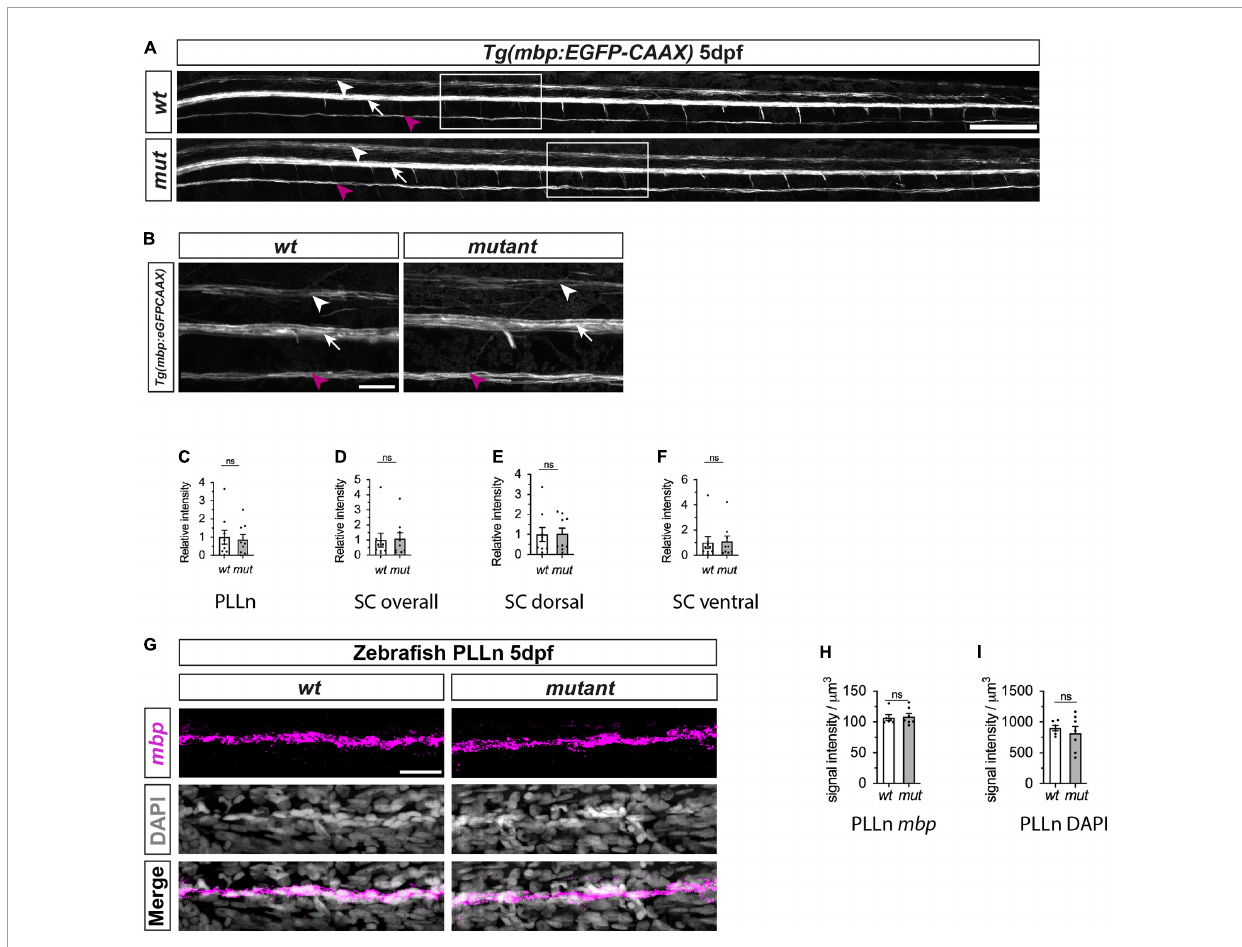
FIGURE4 Myelination of PLLn and spinal cord is unaffected by absence of functional Sarm1 in zebrafish. (A) Max projection of the lateral view of wild-type ( wt ) Tg[mbp:EGFP-CAAX] and sarm1 SA 11193 / SA 11193 ( sarm1 mutant , mut ) Tg[mbp:EGFP-CAAX] 5dpf larva. Arrowhead (white) delineates the dorsal spinal cord; Arrow (white) marks the ventral spinal cord; Arrow (magenta) pinpoints the PLLn. Scale bar 100 µ m. (B) Zoomed in lateral view of spinal cord and PLLn (area indicated by boxes in A ). Arrowhead (white) delineates the dorsal spinal cord; Arrow (white) marks the ventral spinal cord; Arrow (magenta). Scale bar 25 µ m. (C) Relative intensity of GFP in PLLn of Tg[mbp:EGFP-CAAX] wt , 1.0 ± 0.38and sarm1 mutant ( mut ), 0.86 ± 0.28 (mean and SEM, n = 9; p = 08633). (D) Relative intensity of GFP in the dorsal and ventral spinal cord combined of Tg[mbp:EGFP-CAAX] wt, 1.0 ± 0.44 and sarm1 mutant, 1.08 ± 0.38 ( mut ) (mean and SEM, n = 9; p = 08633). (E) Relative intensity of GFP in the dorsal spinal cord of Tg[mbp: EGFP-CAAX] wt , 1.0 ± 0.35 and sarm1 mutant ( mut ), 1.03 ± 0.28 (mean and SEM, n = 9; p = 09314). (F) Relative intensity of GFP in the ventral spinal cord of Tg[mbp:EGFP-CAAX] wt , 1.0 ± 0.48 and sarm1 mutant ( mut ), 1.1 ± 0.44 (mean and SEM, n = 9; p = 08633). (G) MAX projection, lateral view of PLLn of wt and sarm1 mutant ( mutant ) 5dpf larvae showing mbp (magenta) mRNA expression. Nuclei labeled with DAPI (gray). Scale bar 25 µ m. (H) Quantification of mbp mRNA signal intensity/um in PLLn of wt, 107.0 ± 4.72 and sarm1 mutant , 108.82 ± 5.14 ( mut ) 5dpf larvae (mean and SEM, WT n = 6; MUT n = 7; p = 0.8357). (I) Quantification of DAPI signal intensity/ µ m in PLLn of wt , 902.5 ± 45.2 and sarm1 mutant ( mut ), 822 ±